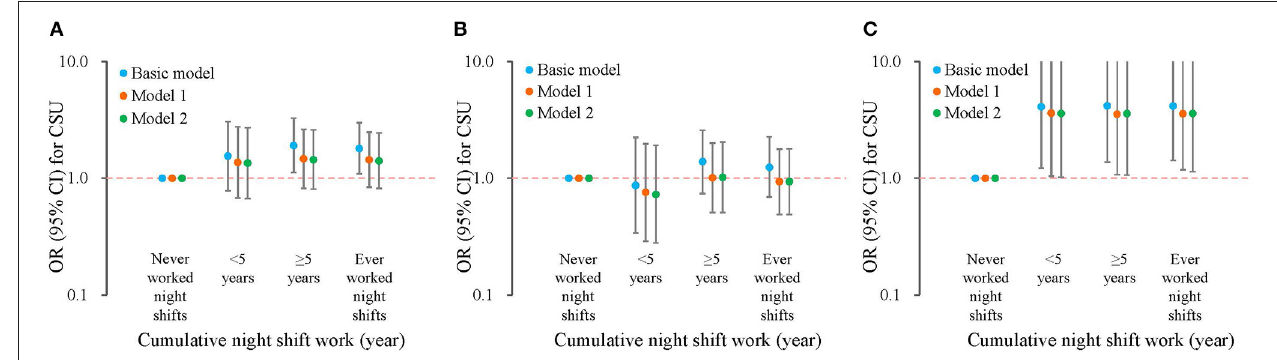
FIGURE 2 | Association of night shift work and chronic spontaneous urticaria, stratified by excessive daytime sleepiness. The basic model was adjusted for age and gender; model 1 was additionally adjusted for ethnicity, marital status, income, educational level; model 2 was additionally adjusted for smoking, passive smoke exposure, alcohol drinking, anxiety, and depression. Logarithmic axis was used for odds ratios. (A) All participants; (B) participants without EDS; (C) participants with EDS. CSU, chronic spontaneous urticaria. EDS, excessive daytime sleepiness; OR, odds ratio; CI, confidence interval.